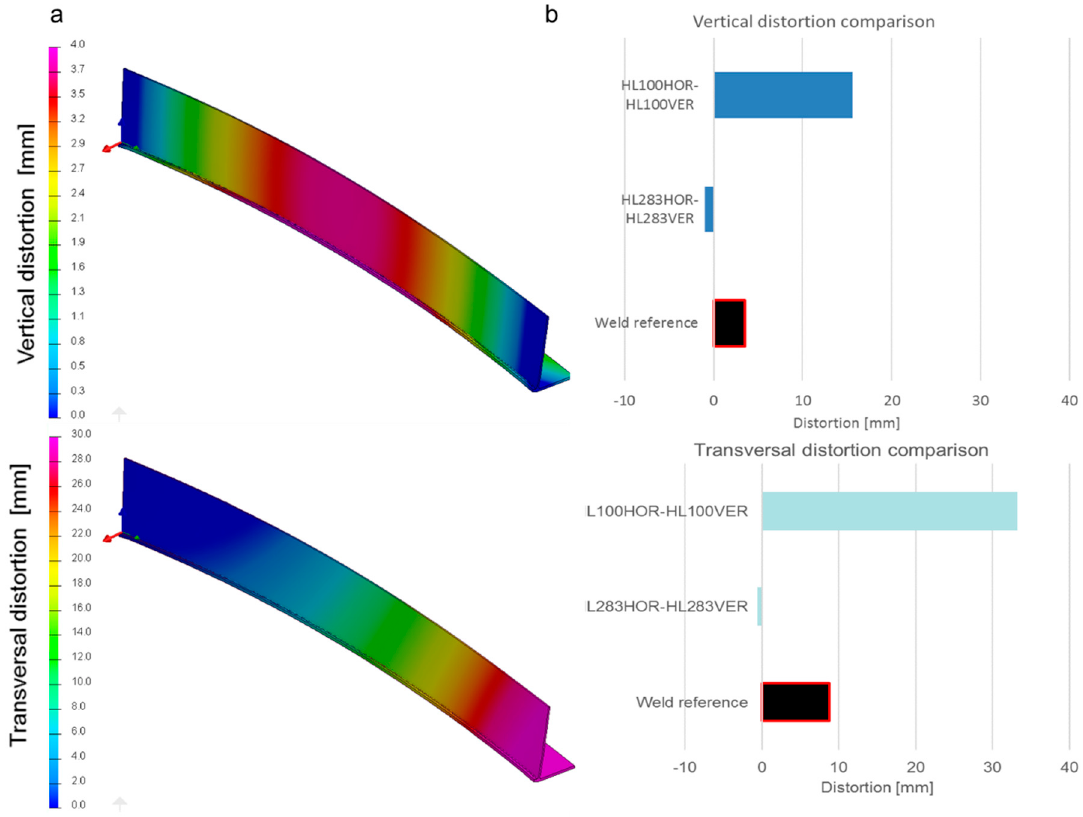
Figure 10. ( a ) P2 distortion results on the reference non-symmetrical weld (mm); ( b ) results of the distortion with htTTT.